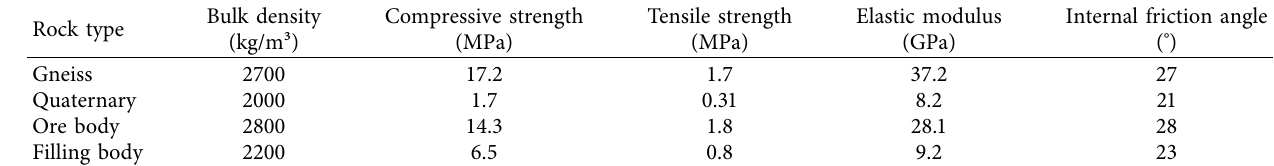
Figure 4: The vertical projection map of mining status. Table 1: Mechanical parameters of the rock